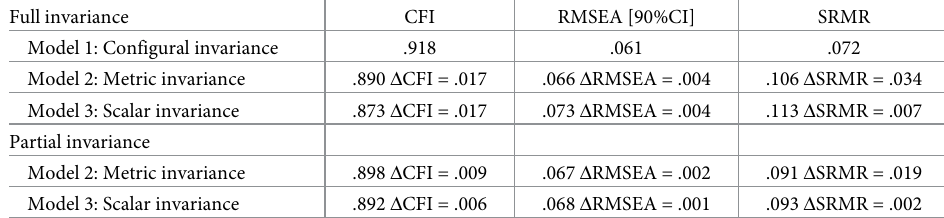
Table 1. Measurement invariance across gender.